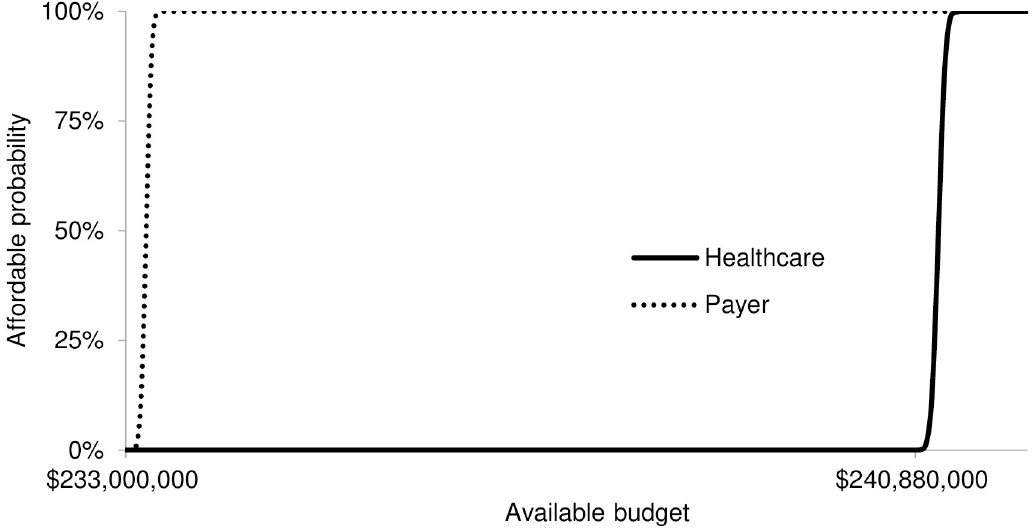
Fig 6. Affordability curves from the healthcare and payer